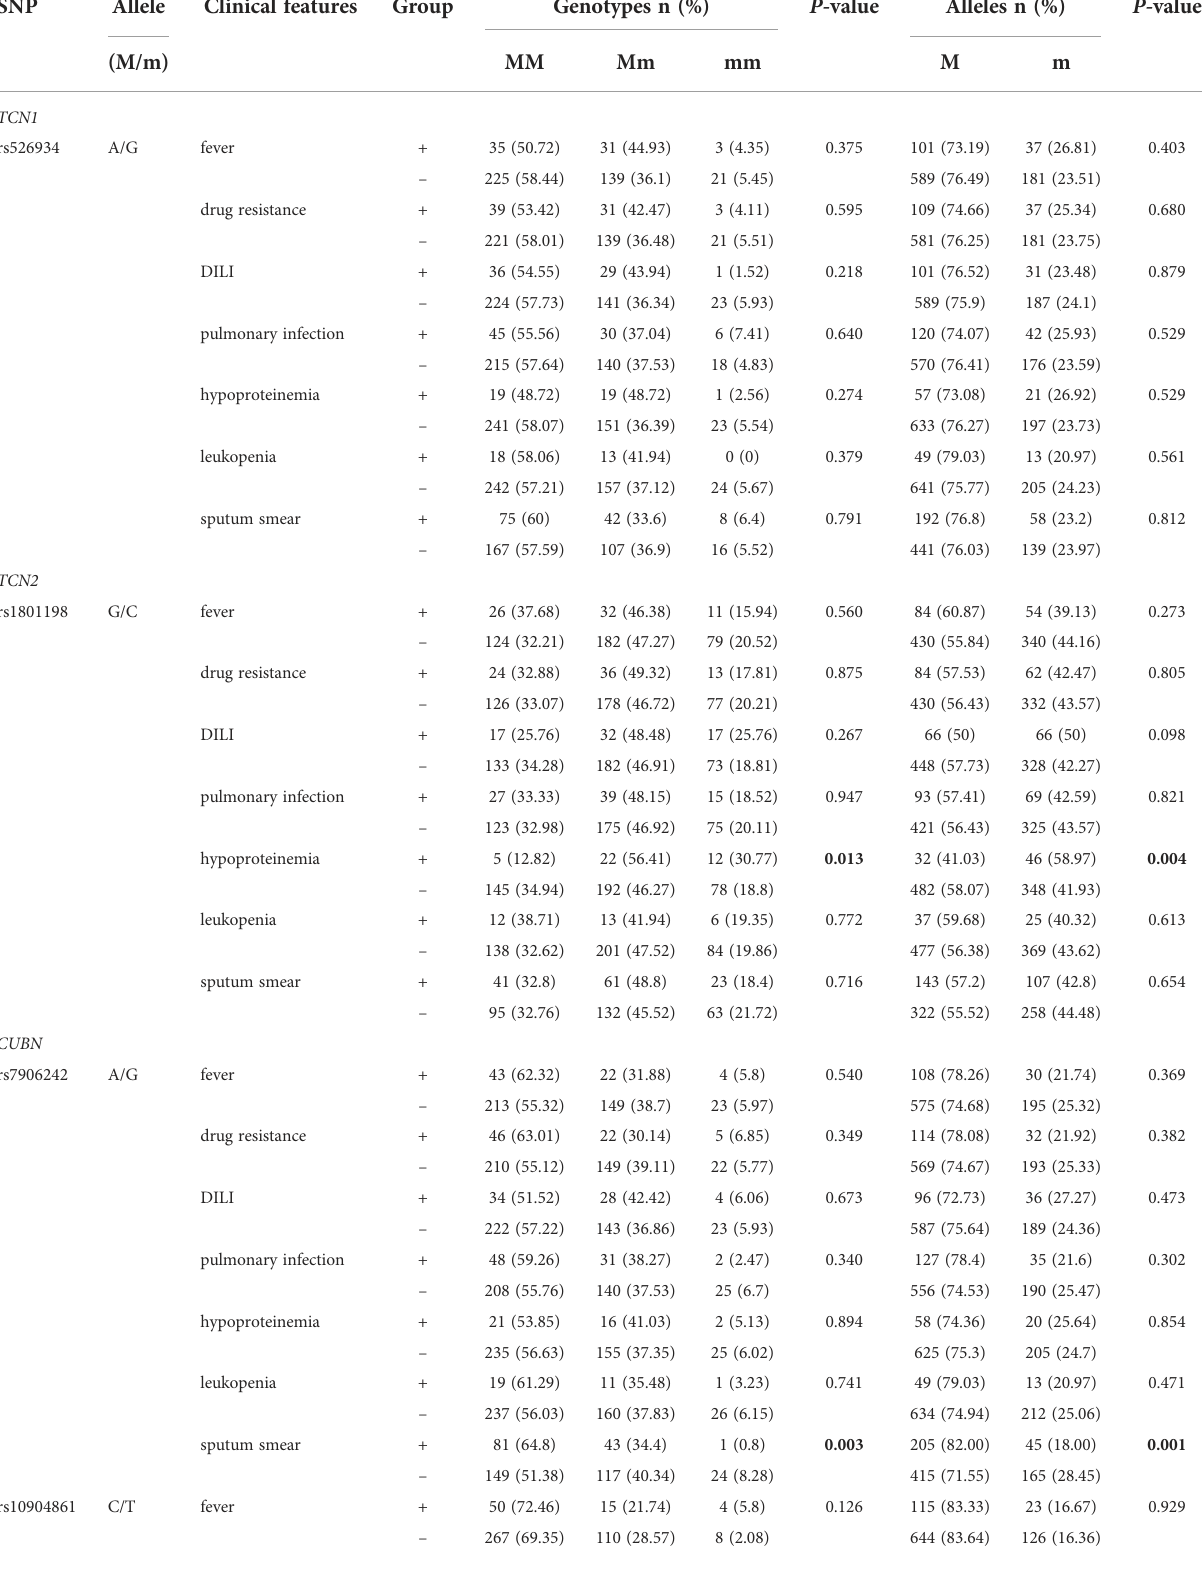
TABLE 2 Association of vitamin B12 metabolic genes polymorphisms with the clinical manifestations of PTB. SNP